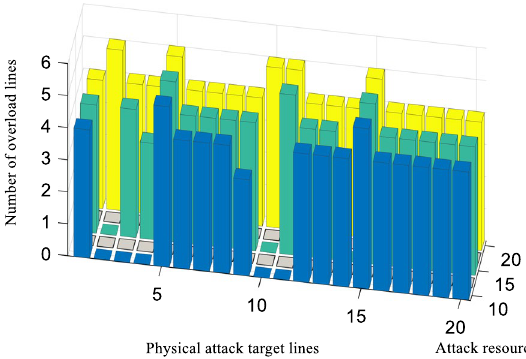
Fig. 8 Number of overloaded lines under different attack resources